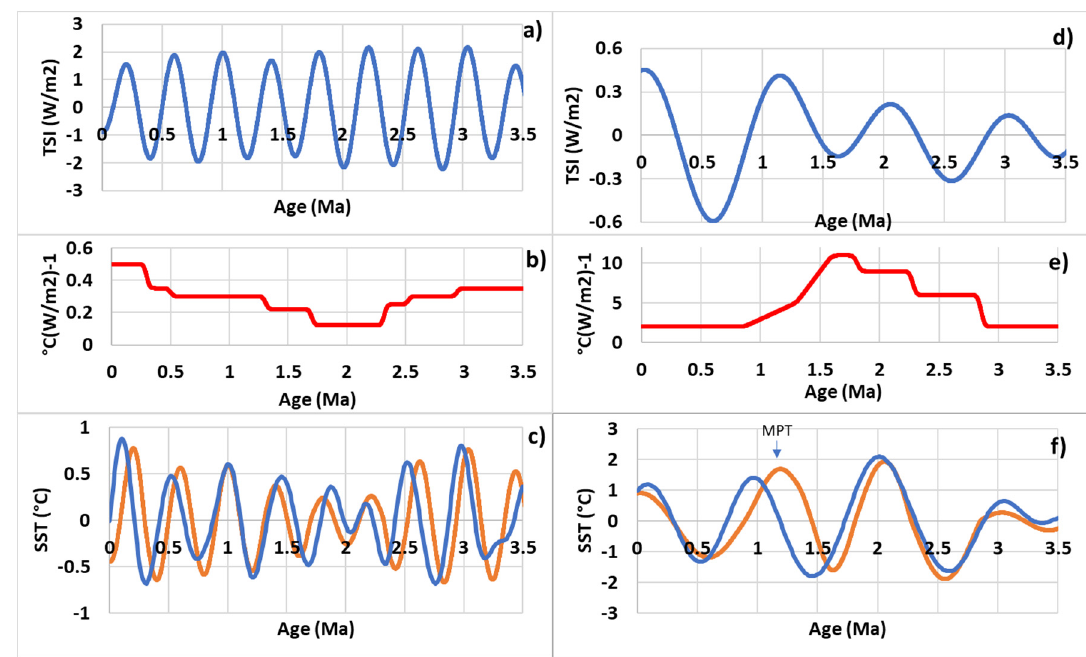
Figure 5. Orbital forcing and SST response into the band 295–590 Ka—( a ) Total solar irradiance (TSI)—( b ) Forcing efficiency—( c ) Comparison of the TSI multiplied by the forcing efficiency from ( b ) in red and the SST in blue—( d – f ) same as ( a – c ) transposed to the band 590–1769 Ka.